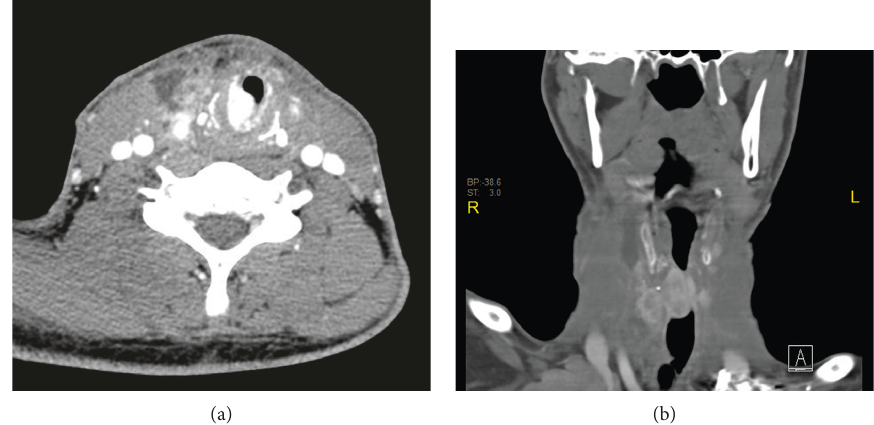
Figure 1: Contrast-enhanced CT showing subglottic soft tissue mass extending at the level of C4, C5, C6, C7 vertebrae, causing marked narrowing of the airways. (a) is axial view and (b) is coronal view.